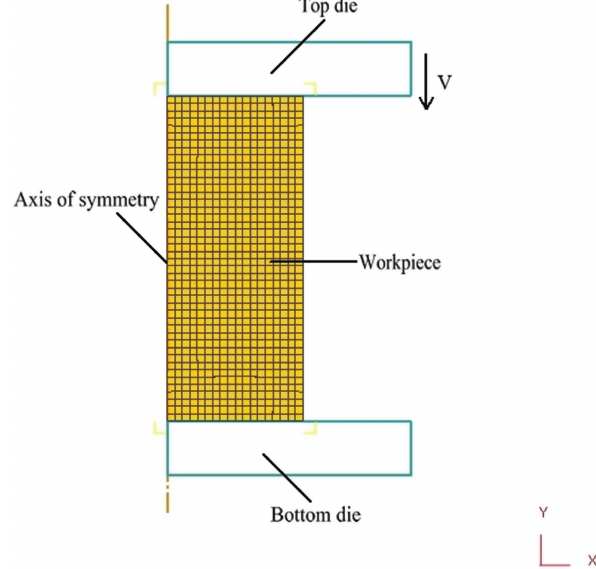
Figure 3: The basic FE model of compression testing in